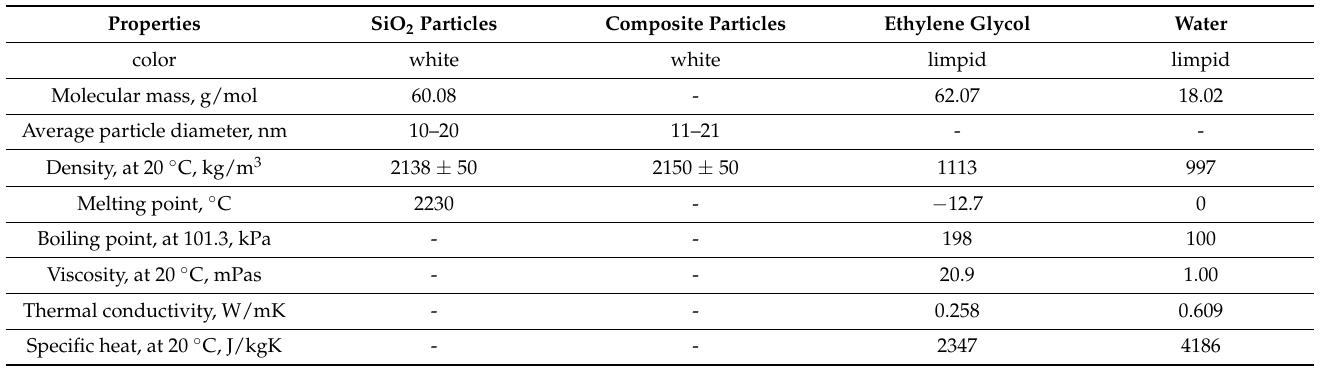
Table 3. Properties of the applied particles and